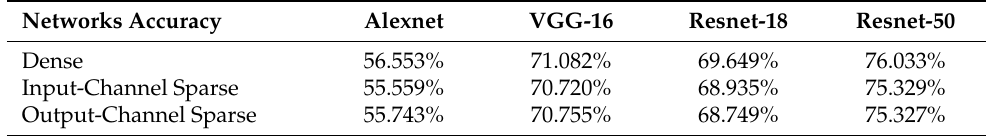
Table 3. Networks Performance Comparisons with N : 16 Layer-wise Sparse Patterns.